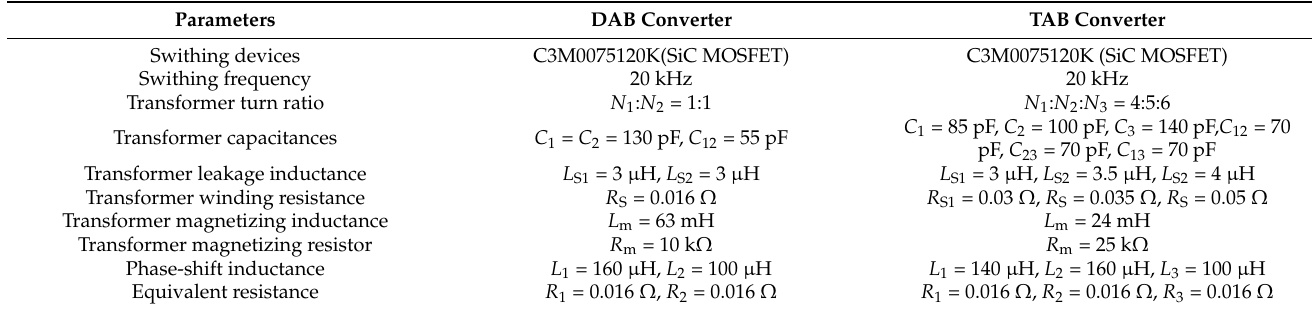
Table 1. Parameters of the DAB and MAB